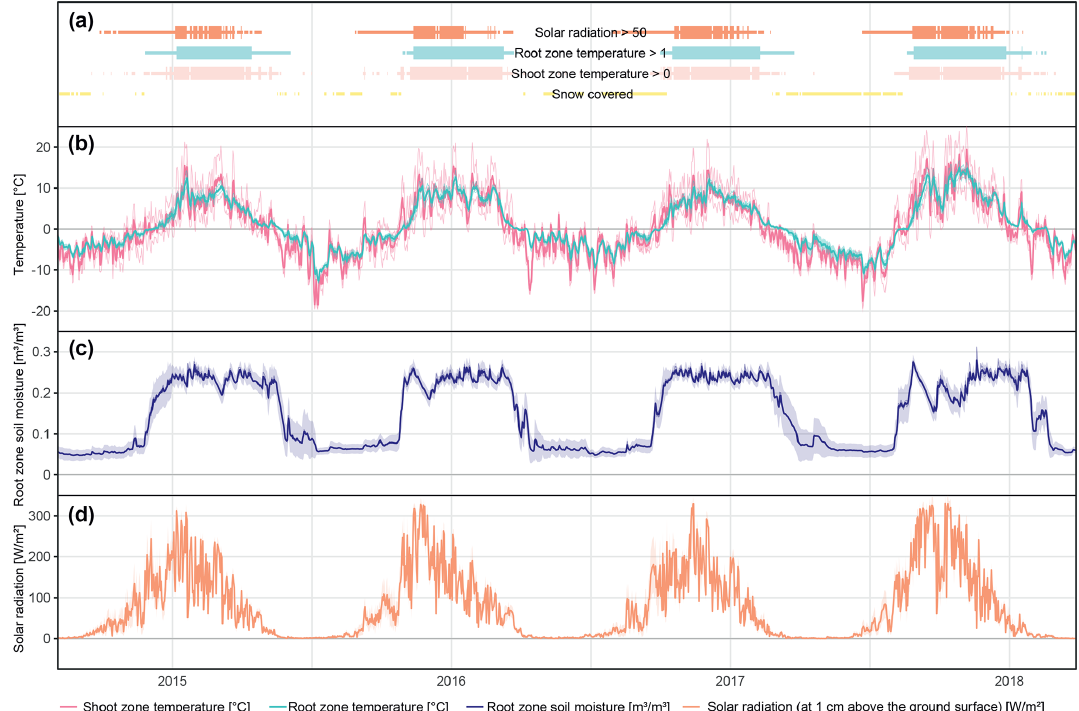
Figure 2. Micro-environmental data. Daily mean values of shoot and root zone temperatures (b) , soil moisture (c) , and global radiation (d) . Measurements were taken at each site individually but were averaged here over all sites for visualization. Shaded areas indicate standard deviations. Bars (a) show time spans for certain environmental conditions, with narrow bars marking the time at which the given condition was present at one or more (but not all) of the monitored sites, whereas broad bars mark the time for which the given condition was detected at all sites.